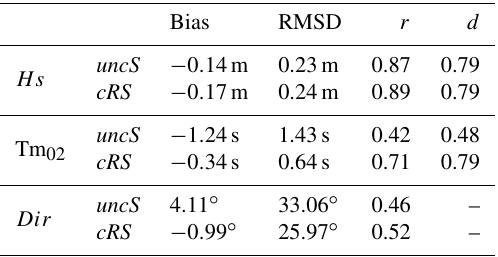
Table 2. Statistics comparing the modeled wave parameters with the CB data.